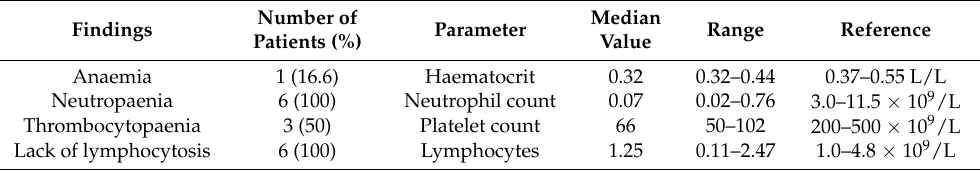
Table 1. Haematology parameters of the patients included in the